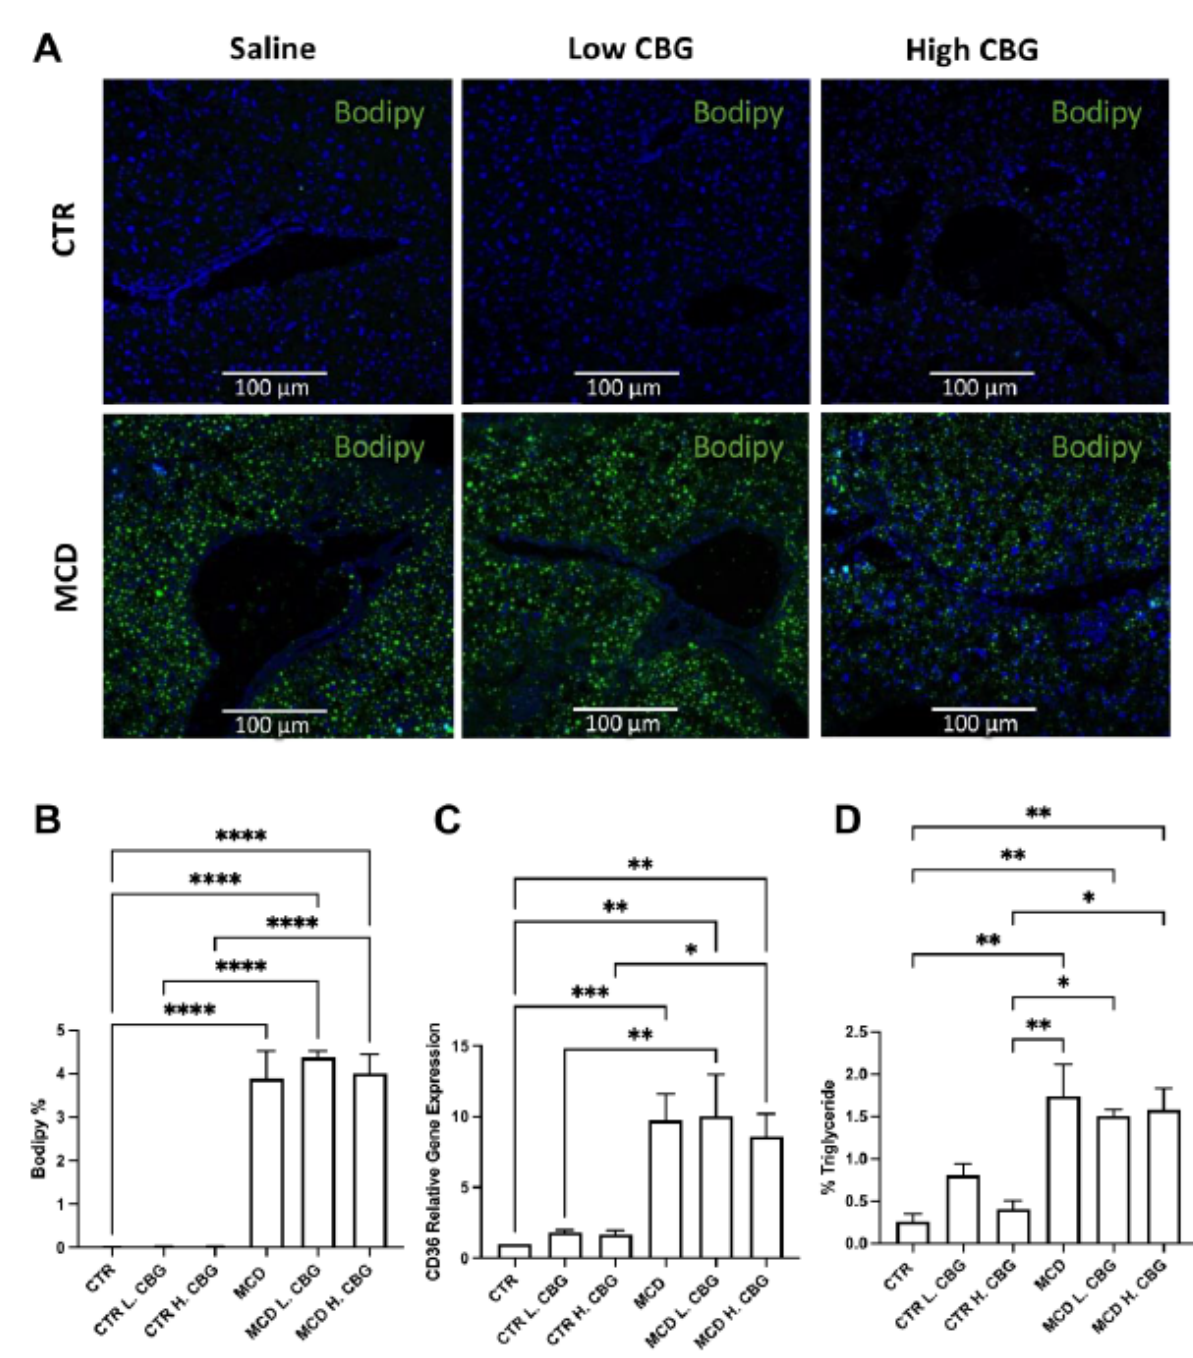
Figure 2. Steatosis was evaluated using histology and RT-qPCR. Immunofluorescence staining of bodipy (green) and DAPI (blue) ( A , 20 × ). Immunofluorescence staining was quantified using ImageJ ( B ). mRNA expression of CD36 ( C ) was measured via RT-qPCR, and the percentage of triglyceride was evaluated using a commercially available ELISA kit ( D ). * p < 0.05, ** p < 0.01, *** p < 0.001, **** p < 0.0001.